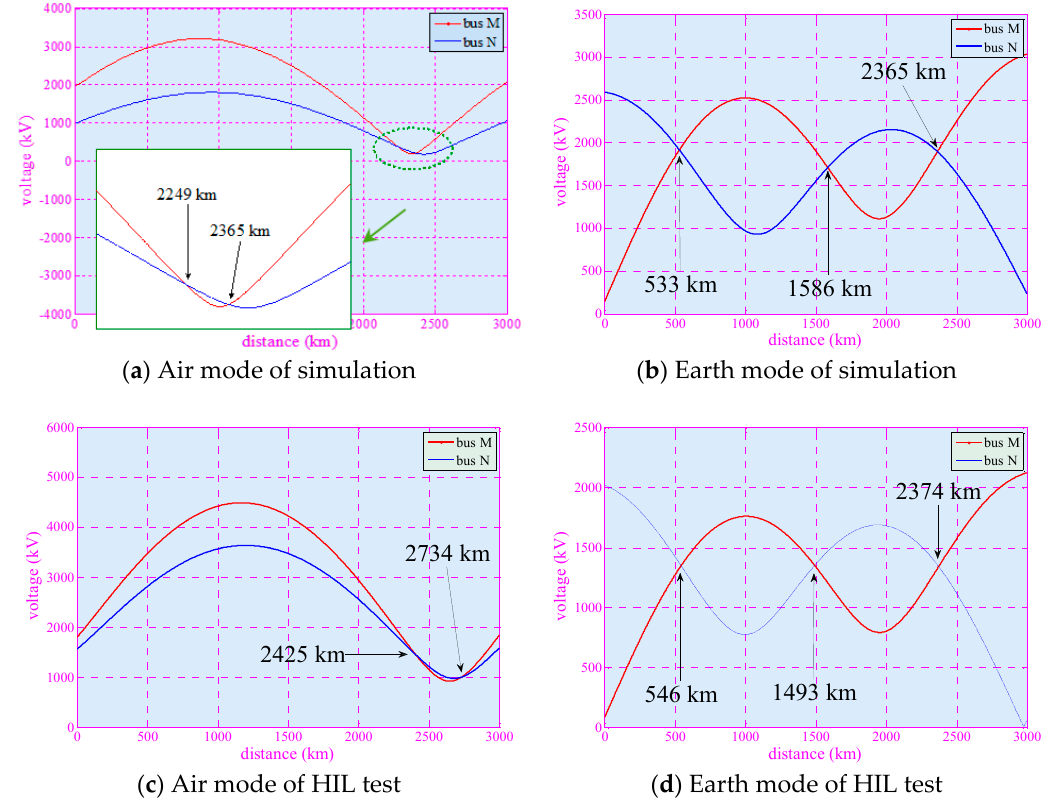
Figure 10. A phase-to-ground (AG) fault with 200 Ω fault resistance, 2400 km away from bus M, with 1800 MW wind power.